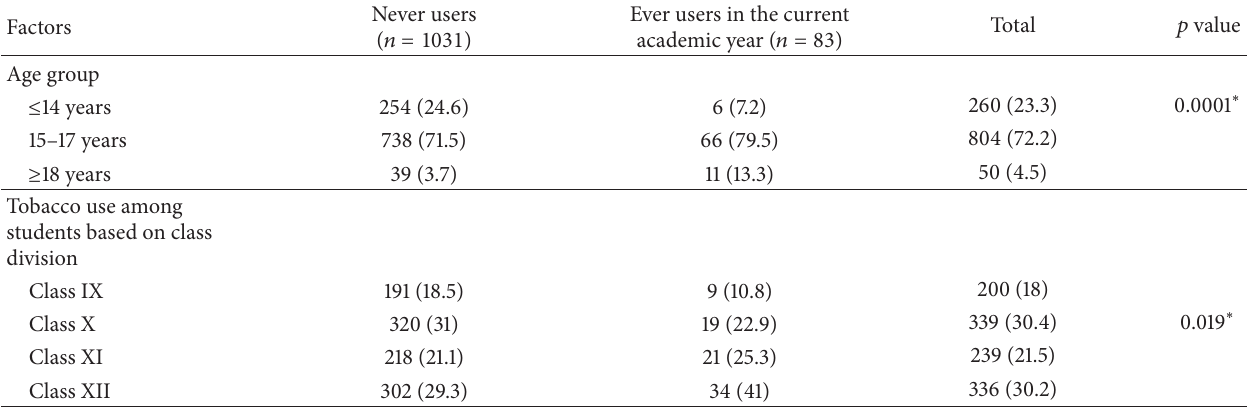
Table 1: Distribution of never and ever users of tobacco in the current academic year based on age group and education. Factors